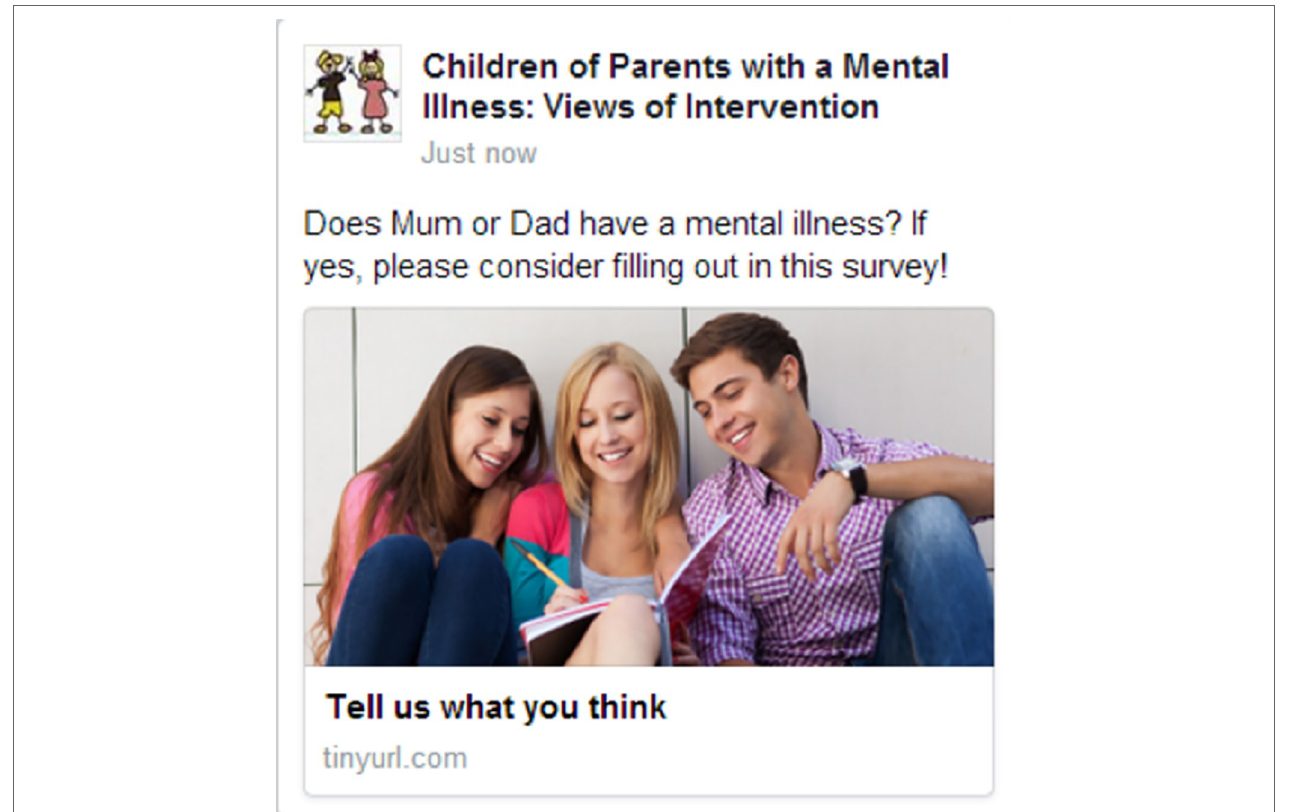
FIGURE 2 | Example of advertisement